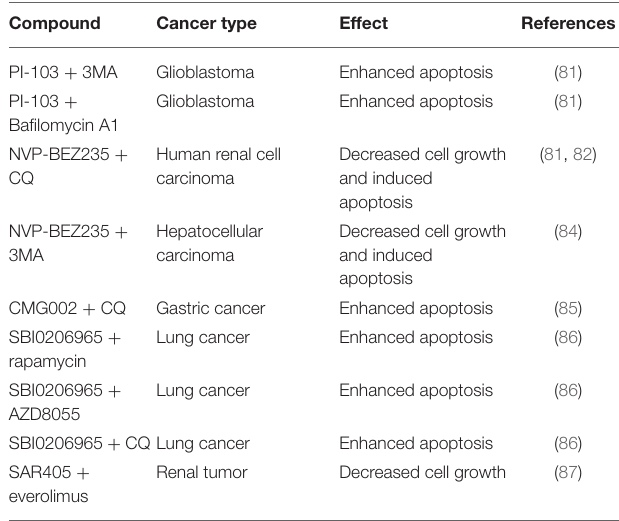
TABLE 2 | Combination therapy with PI3K/AKT/mTOR pathway and autophagy inhibitors for cancer